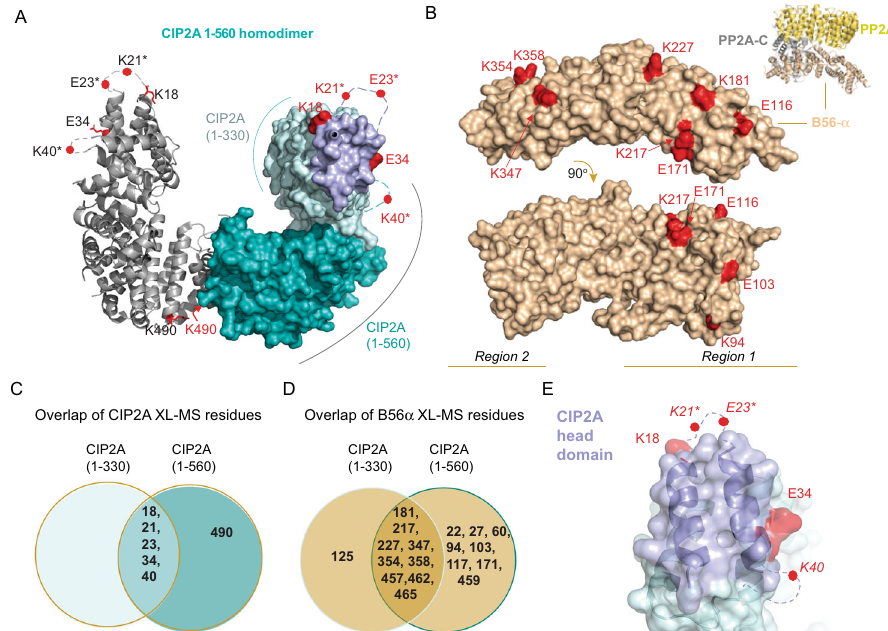
Fig. 1 | CIP2A interacts with B56 α via its N-terminal head domain. A In red are indicated CIP2A(1-560) residues identi fi ed in inter-molecular cross-links to B56 α using DSS and DMTMM cross-linkers. CIP2A 1-560 homodimer (PDB: 5UFL) monomers are shown either as ribbon or space fi lling models. In the space fi lling model 1-330 amino acids are in cyan including in purple the CIP2A head domain identi fi ed in this study. The 331-560 region including the dimerization domain is shown as turquoise. Due to high molecular fl exibility of the N-terminal region of CIP2A, positions of residuesK21 and E23 (indicated with*)hadto be approximated using A24 position and K40 using position of R43. B Distribution of B56 α (PDB: 6NTS)residuescross-linkedtoCIP2AbyusingDSSandDMTMMchemistries.Cross-